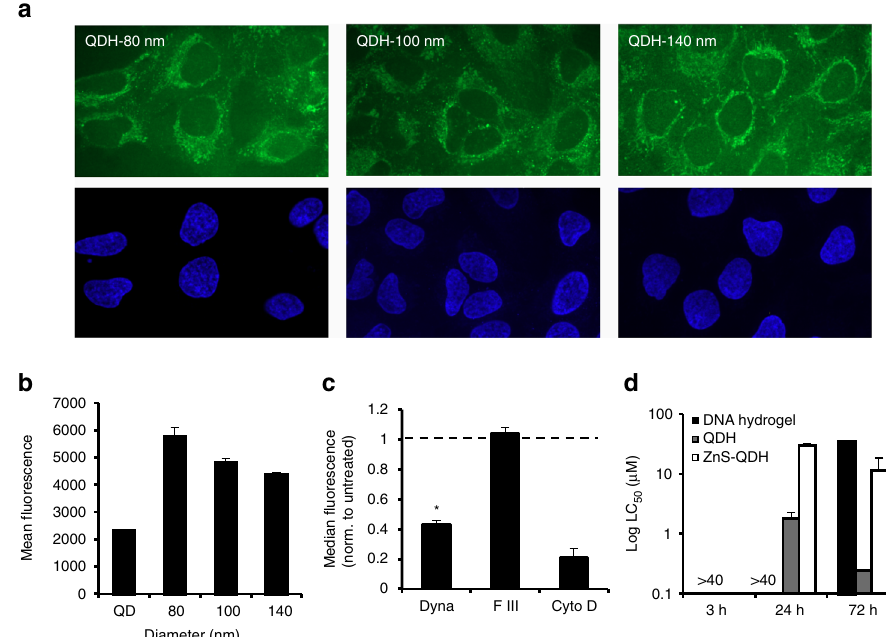
Fig. 4 Uptake and viability of QDHs in cells. a Cellular accumulation of 80 nm, 100 nm, and 140 nm QDH ( green ) excluded from nuclei ( blue ) of HeLa cells. b Quanti fi cation of cellular uptake of QD alone and QDH (80 nm, 100 nm, and 140 nm) in HeLa cells by fl ow cytometry ( n = 3). c Elucidation of endocytic uptake method of 80 nm QDH in HeLa cells by fl ow cytometry ( n = 4). Dyna: dynasore,; F III: fi lipin III; Cyto D: cytochalasin D. One-way ANOVA for treated vs. untreated control * P < 0.01. d Cell viability in HeLa cells. Comparison of LC 50 values of DNA hydrogel, QDH, and ZnS-QDH at 3, 24, and 72 h time points ( n = 3). All error bars represent s.e.m